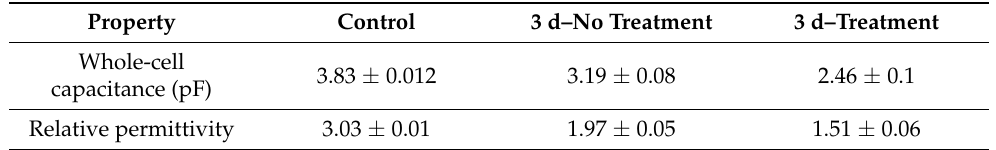
Table 4. Estimated membrane electrical properties using DEP spherical single-shell model, mean ± standard error (SE) are reported for all the cell groups.